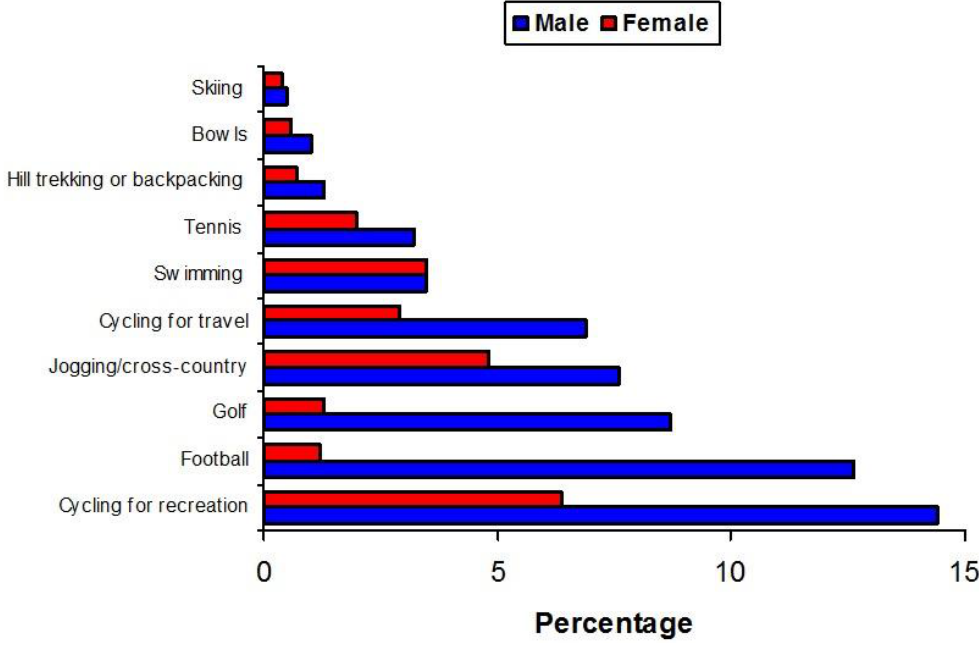
Figure 9. The percentage of British people who engage in various outdoor recreation pursuits [14].